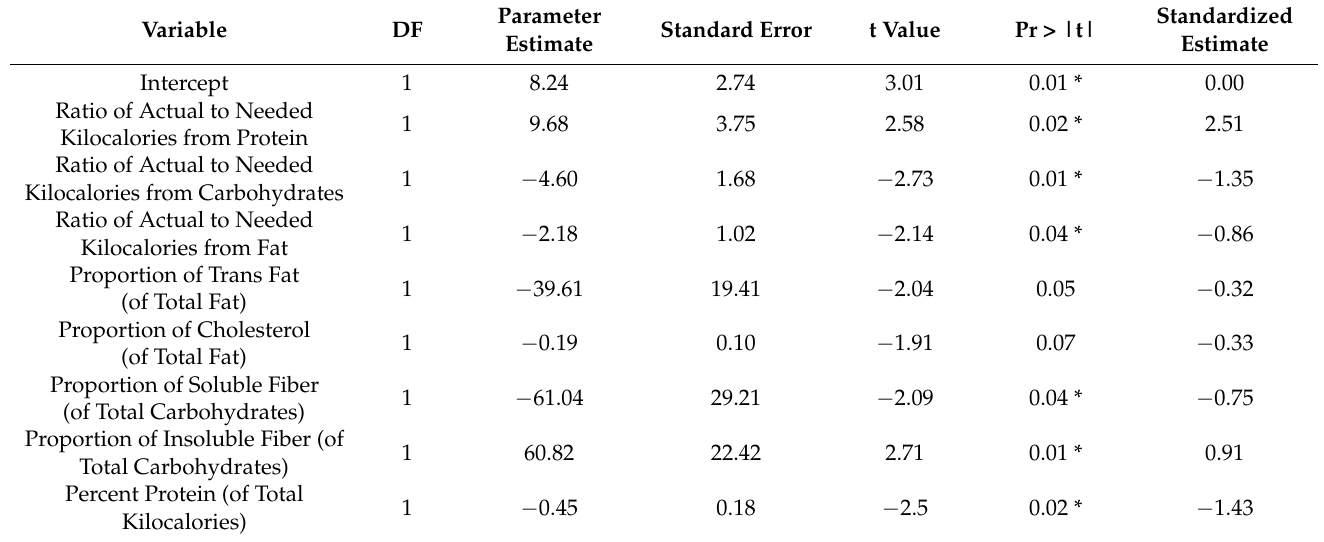
Table 3. Parameter Estimates for Predicting Diabetes Status.